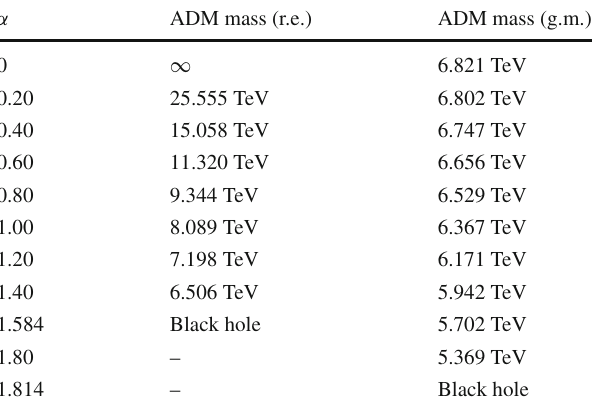
Table 2 The numerical estimate of ADM mass for gravitating monopole (g.m.) and radial excitation (r.e.) with (cid:4) = ( H / H 0 ) 8 and physical value of β α ADM mass (r.e.) ADM mass